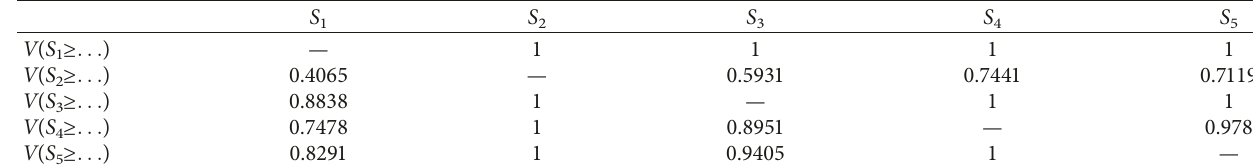
Table 5: Calculations of degree of possibility (V